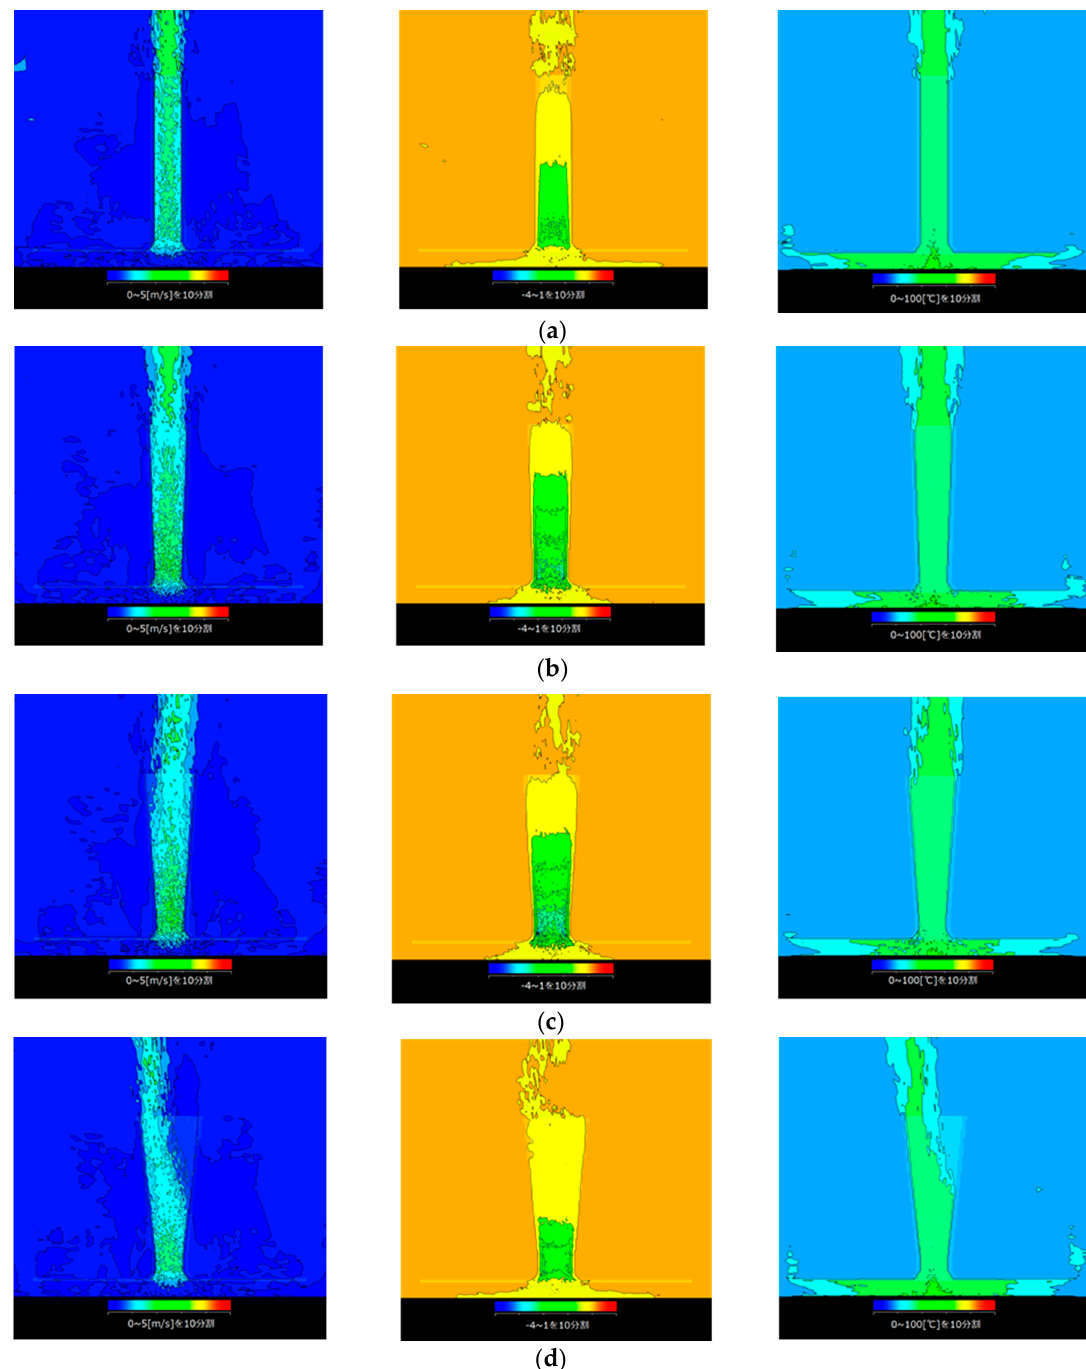
Figure 12. Instantaneous w ( left ); static pressure ( center ); and temperature ( right ) fields of updraft inside the tower with the height h = 2.0 m for each semi-open angle of ( a ) 0° (cylinder); ( b ) 2°; ( c ) 4° and ( d ) 6°. w , static pressure and temperature is expressed by 10 intervals between 0 and 5 m/s ( w speed), − 4 and 1 (dimensionless static pressure), 0 and 100 °C (temperature), respectively.